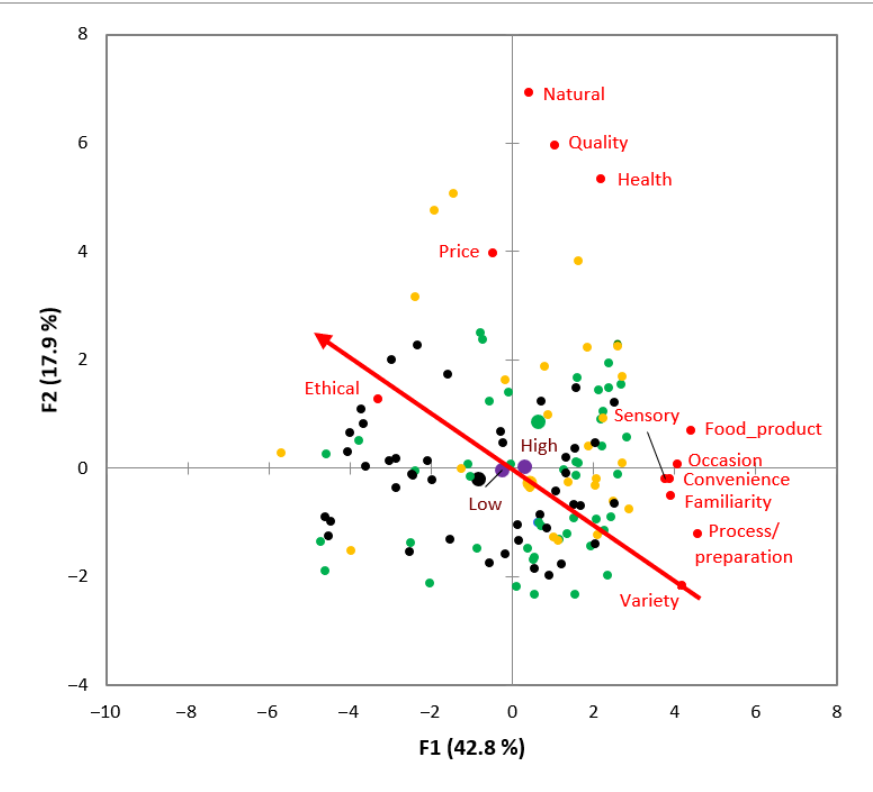
Figure 5. Overall preference map with the dimensions’ importance for participants and the sup- plementary variables: black, German participants; green, French participants; and yellow, Spanish participants. Country totals are expressed in broader coloured points: purple, consumers’ fish consumption (high or low). The red arrow indicates the vector model of preference.